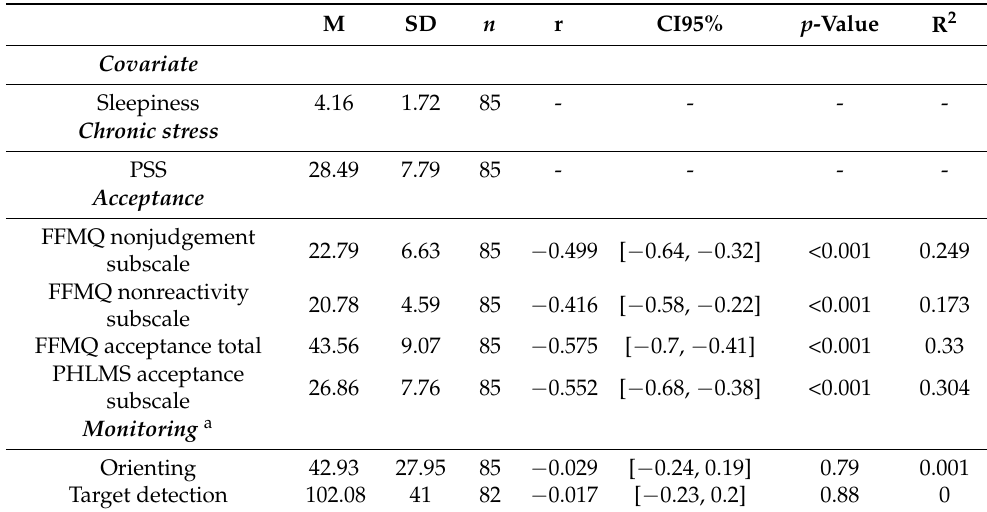
Table 3. Correlations (r), 95% confidence intervals (CI95%), p -values, and R 2 values between each experimental variable and chronic